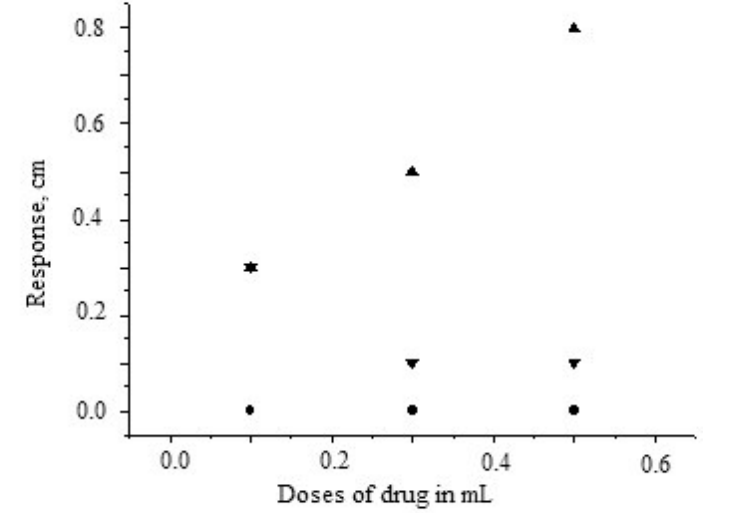
Figure 2 . Responses of rectus abdominus muscle of frogs to acetylcholine ( (cid:1) ), acetylcholine-plant extract( (cid:2) ), acetylcholine-pancronium bromide ( (cid:3)